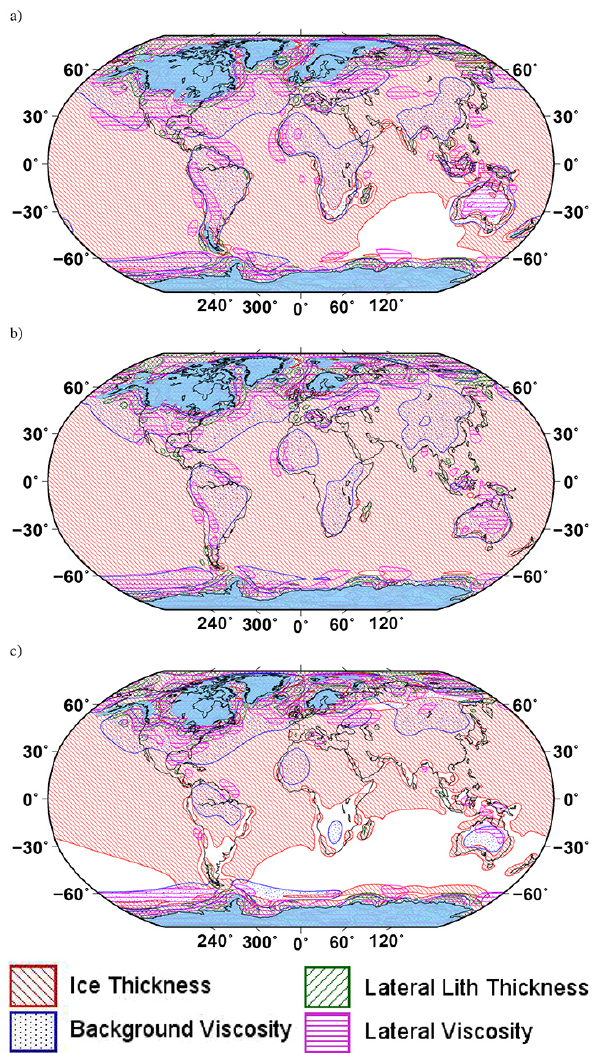
Figure 6. Same as Fig. 5, but for (a) 9, (b) 8 and (c)